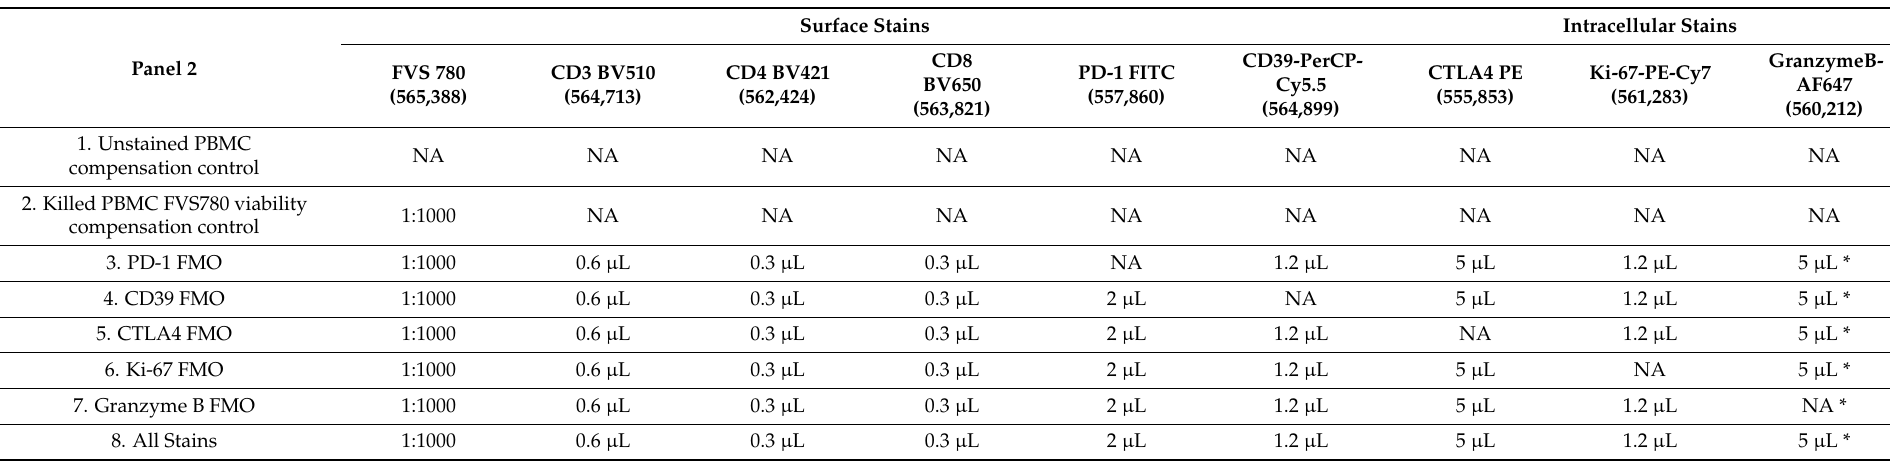
Table A3. Amount of Surface and intracellular staining reagents for panel